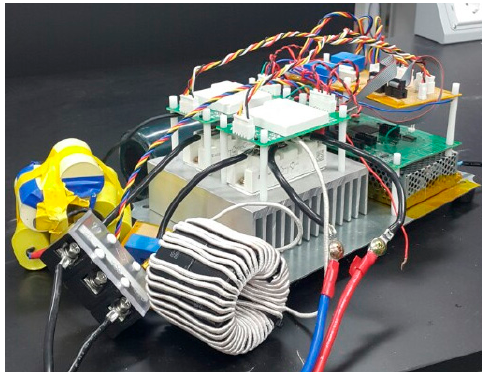
Figure 16. Developed single-phase inverter prototype.